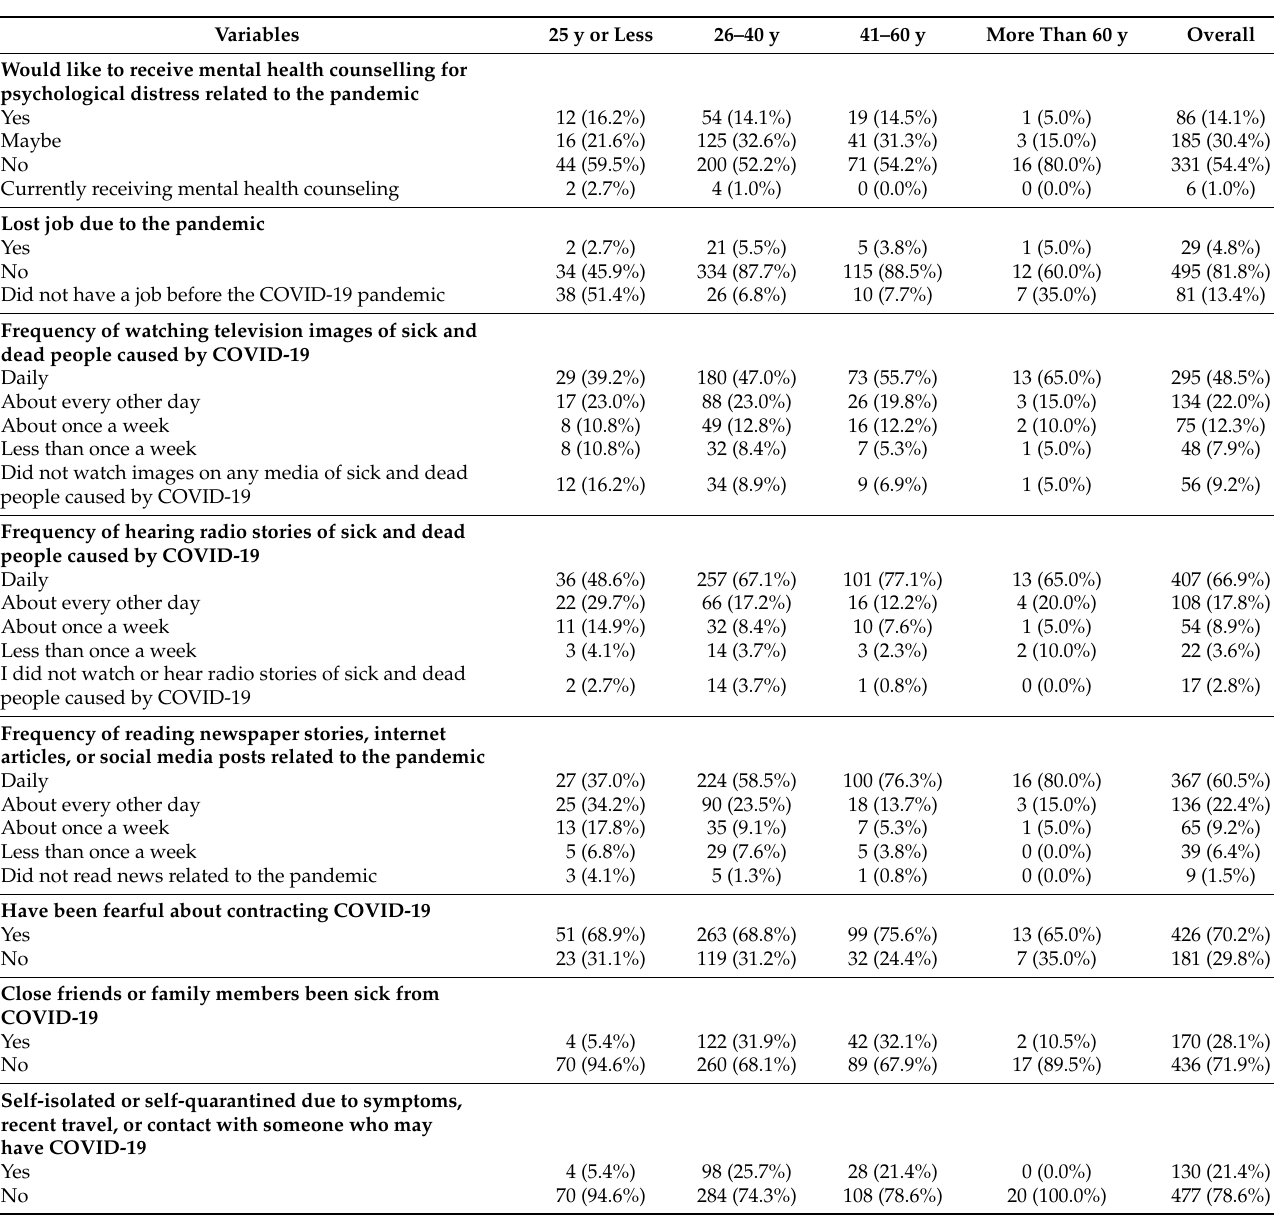
Table 2. Age distribution of social, clinical and COVID-19 related characteristics of